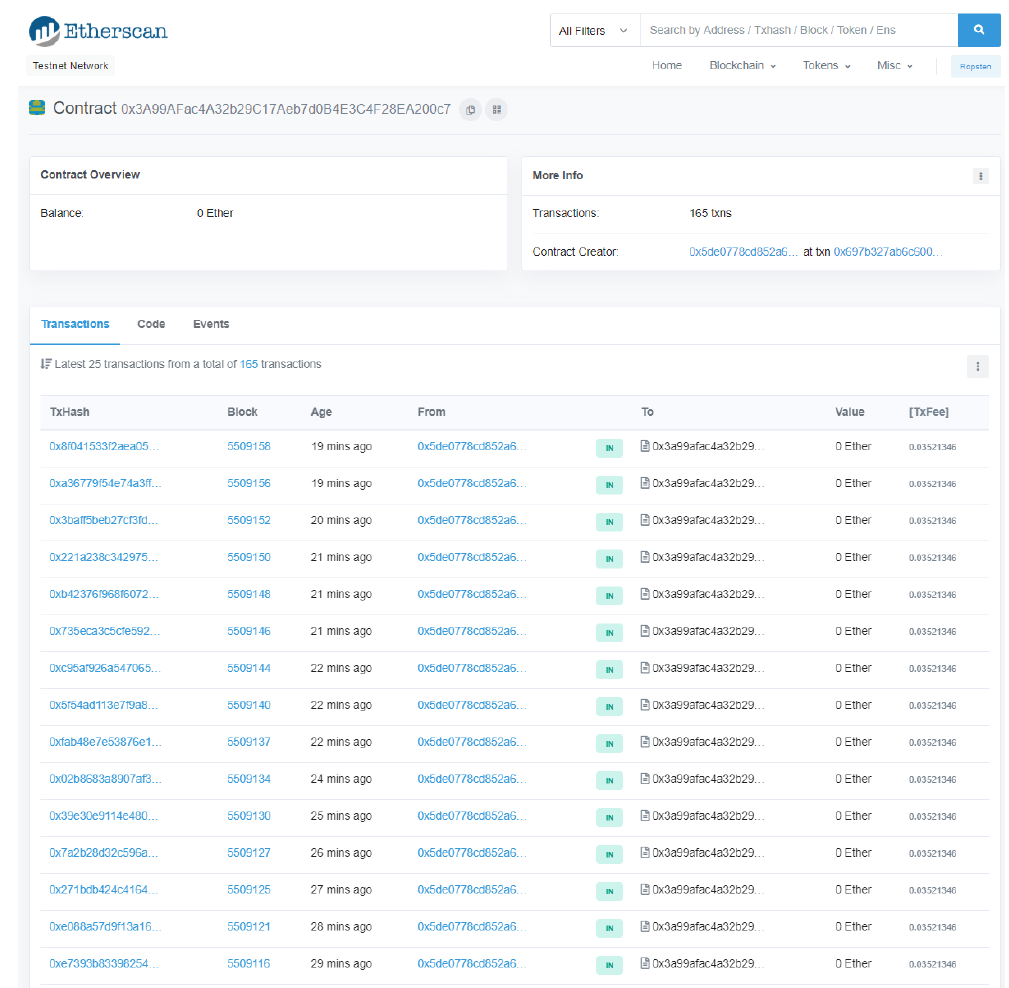
Figure 18. Caption of Ropsten Testnet